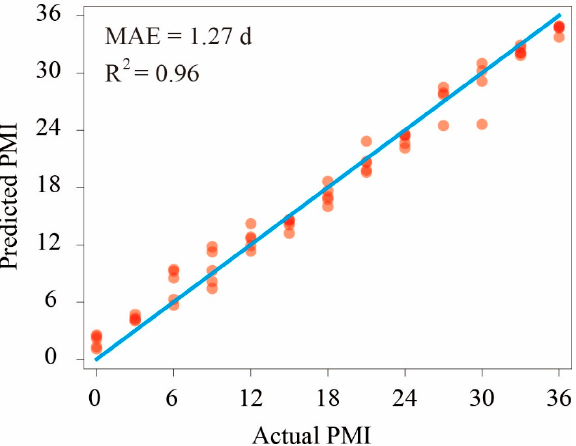
Figure 5. Random forest regression model. Each red dot represents a gravesoil sample. The blue straight line represents the predicted value, and the actual values are equal.